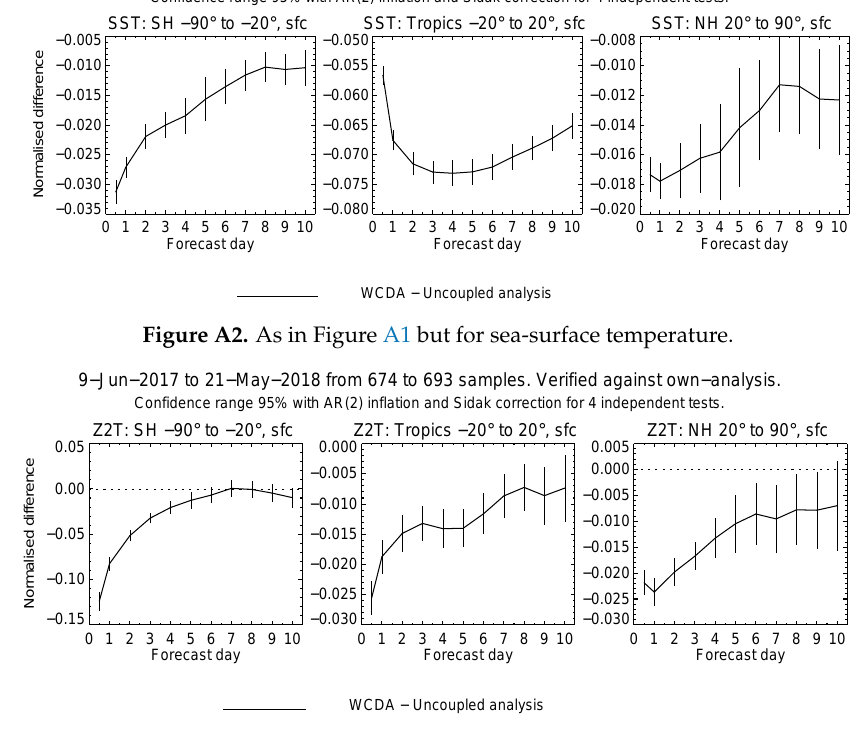
Figure A3. As figure A1 but for atmospheric 2 metre temperature. Figure A3. As in Figure A1 but for atmospheric 2-m